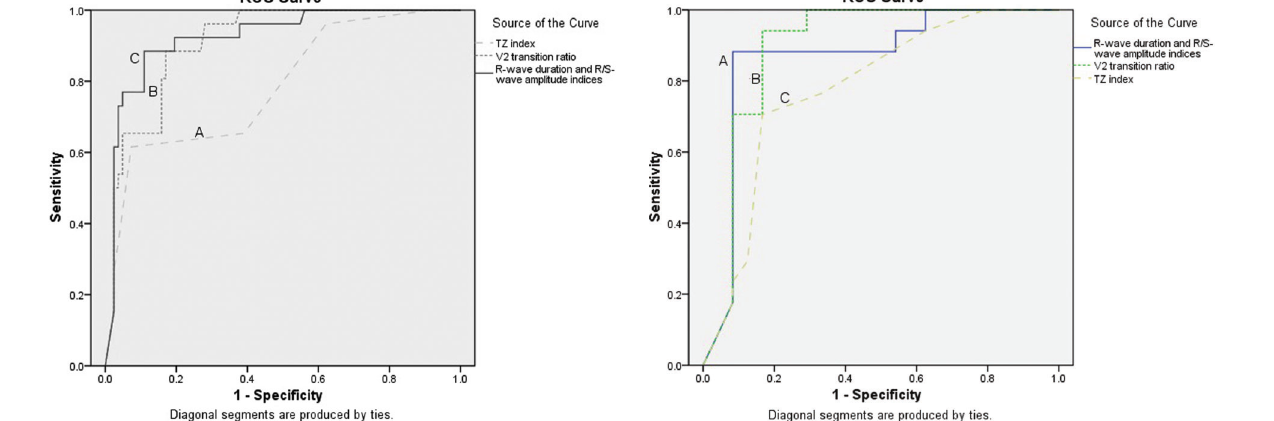
Figure 2. AUCs of the three algorithms in all patients. AUC A : transitional zone (TZ) index=0.84, B : V 2 transitional ratio=0.91, C : V 2 R wave duration and R/S wave amplitude indices = 0.925. Pairwise comparison: A and B (P=0.0082), A and C (P=0.0051), B and C (P=0.4711).